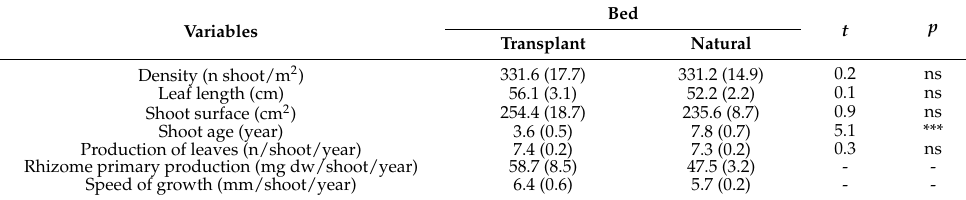
Table 1. Comparison outcomes for density, leaf biometry and dating between beds. Significance: *** p < 0.001; ns p > 0.05. Standard error in brackets. (-) Statistical test not performed (see Methods